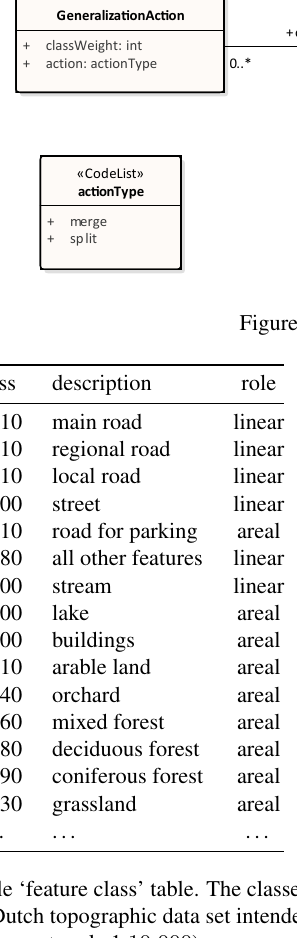
Table: feature class Within this table all feature classes are stored that are present in the source data set, together with a